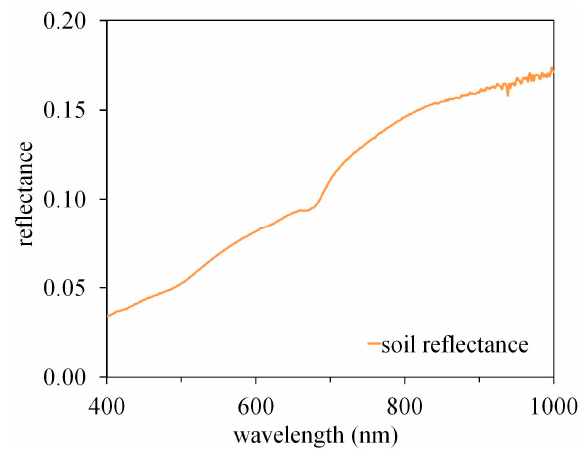
Figure 1. The soil reflectance used for PROSAIL simulations.